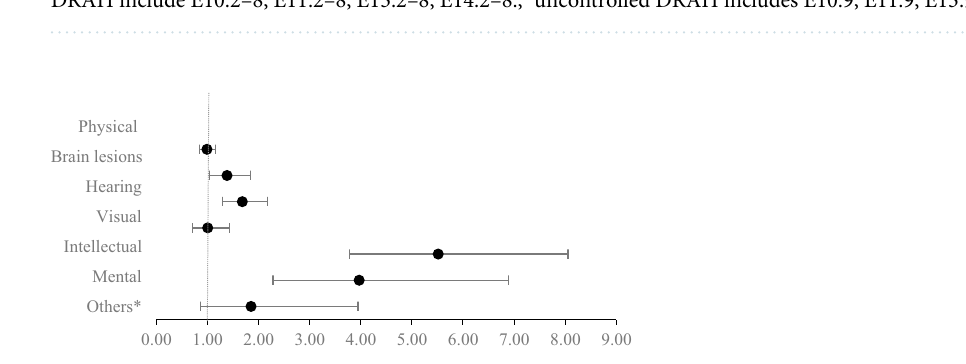
Figure 2. Association between disability types and diabetes-related avoidable hospitalization. AHR Adjusted Hazard Ratio. Adjusted for sex, age, region, income, insurance type, CCI, DCSI score, Year * Others include autistic disorder, cardiac dysfunction, respiratory dysfunction, hepatic dysfunction, facial disfigurement, intestinal fistula and urinary fistula,